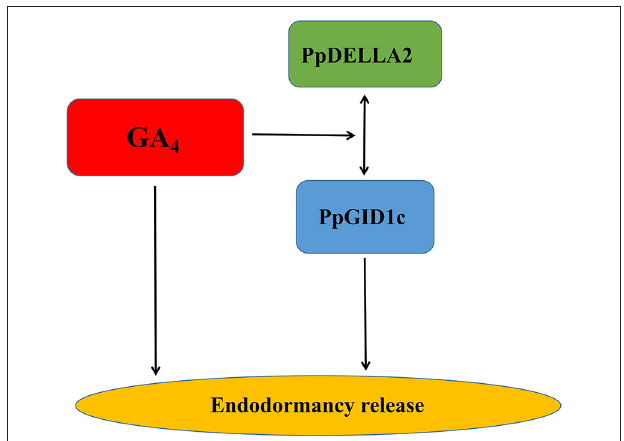
FIGURE 6 | A simple model representing the role of GA 4 -PpGID1c-PpDELLA2 in the regulation of peach leaf bud endodormancy